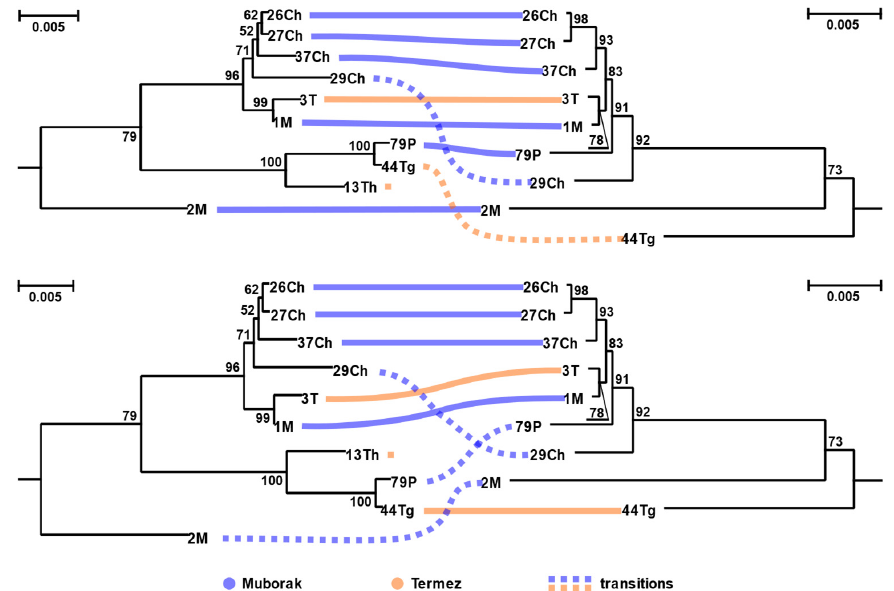
Figure 3. Juxtaposition of subtrees for Leishmania major and the corresponding LRV2 clade demon- strating the two most parsimonious scenarios of coevolution and host switches. Scale bar indicates the number of substitutions per site. Values at branches are bootstrap supports.